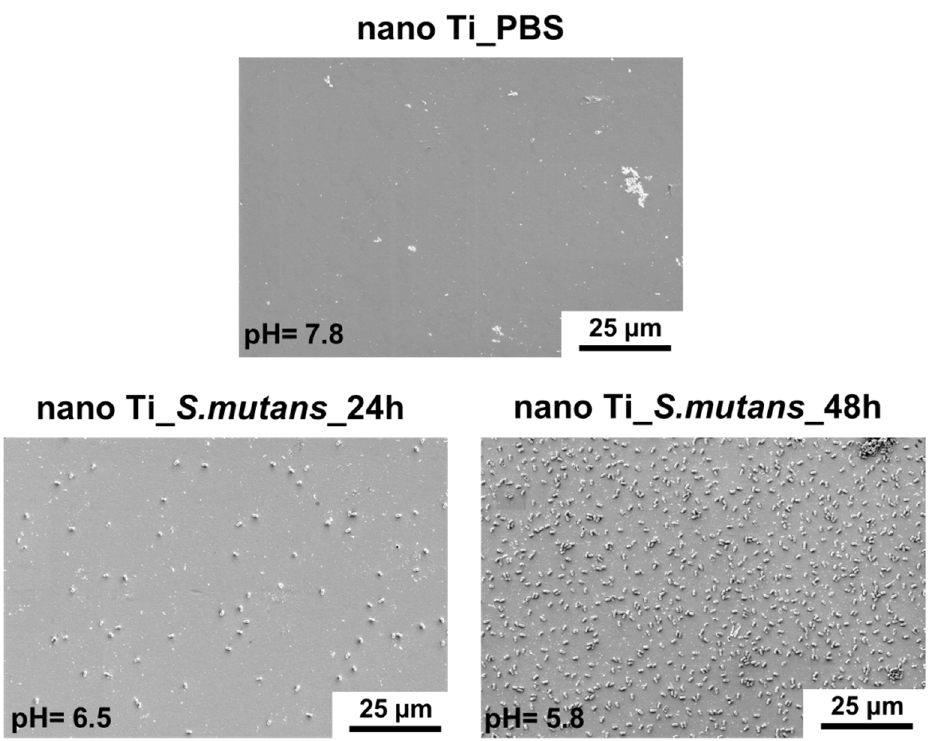
Figure 3. Streptococcus mutans adhesion to the nanostructured Ti surface (SEM micrographs). Table 2. Number of bacteria cells and pH value of the bacteria and control suspensions. Statistical significance of differences between values designated for different samples were confirmed by one ‐ way ANOVA test ( p < 0.05).